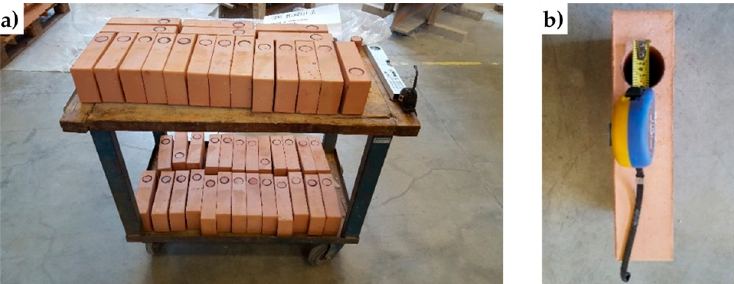
Figure 35. Drilling of the bricks: ( a ) preparation of the bricks and ( b ) detail of a brick after drilling.